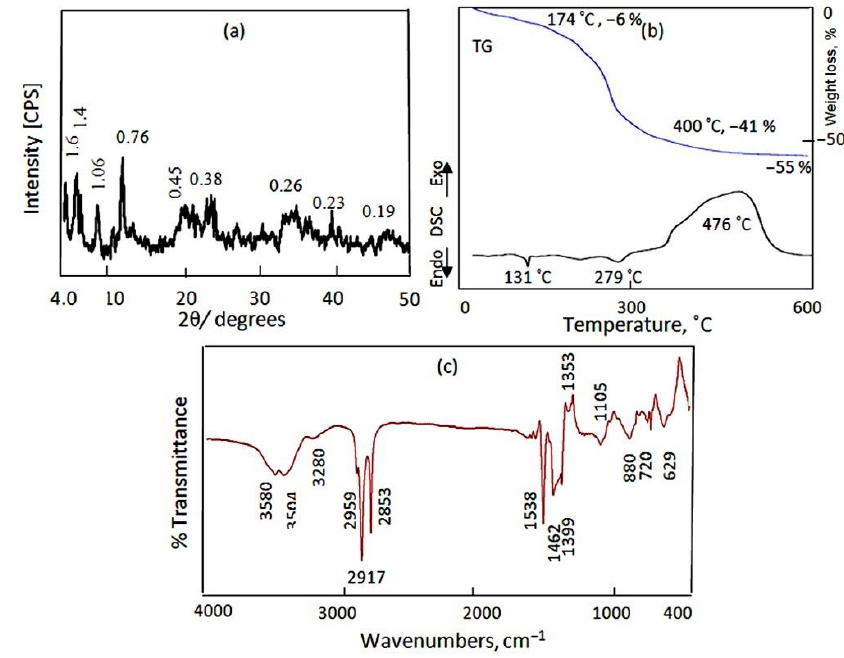
Figure 8. The AZ-3 sample: ( a ) X-ray diffraction, ( b ) thermal analyses and ( c ) FTIR.